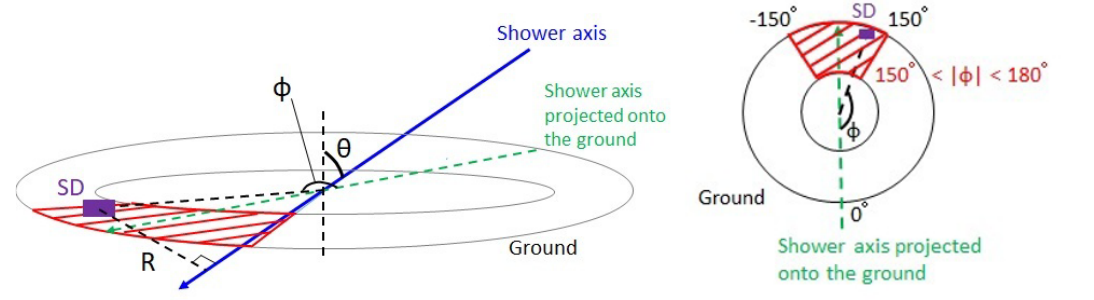
Figure 1. (left) Geometry definition of the muon analysis. There are six bins for ϕ and 18 bins for R from 500 to 4500 m. The red shaded region in the figure shows the bin for 150 ◦ < j ϕ j < 180 ◦ , which is expected to be the bin with less EM background. (right) Top view for the ϕ definition.